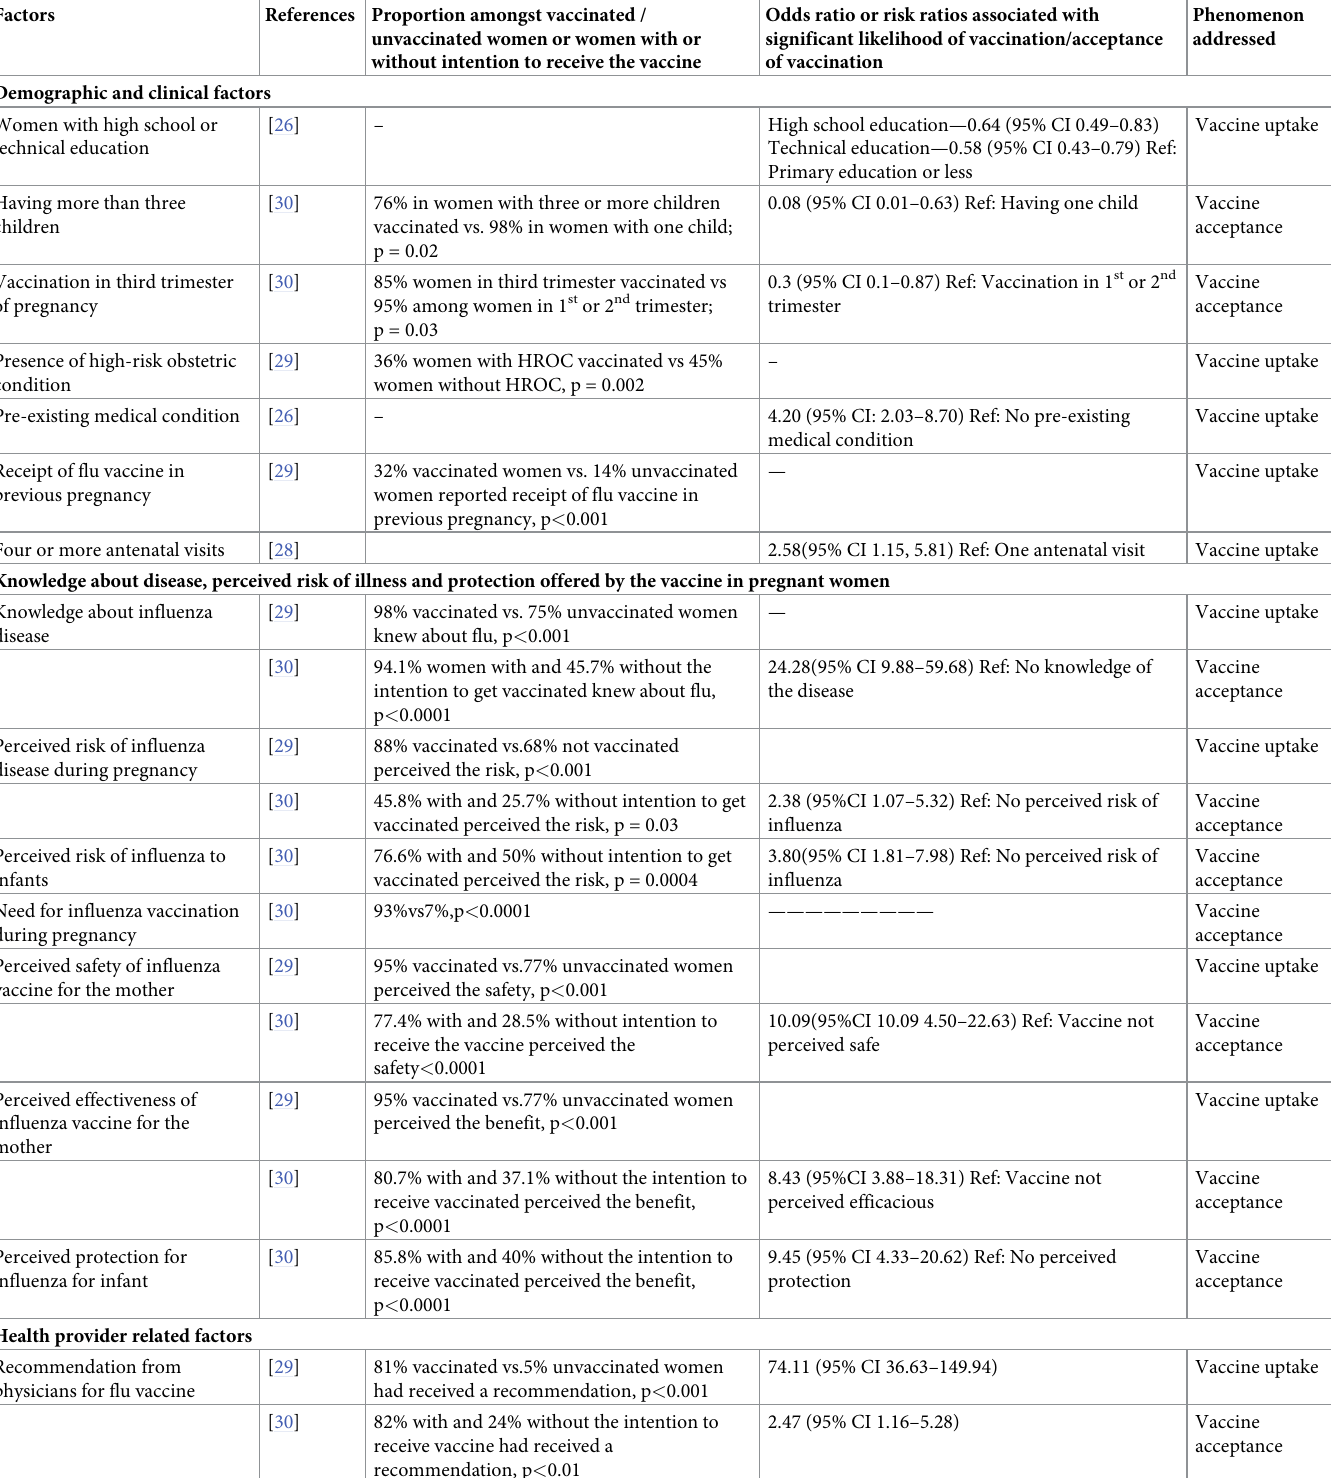
Table 3. Factors associated with uptake and acceptance of maternal influenza vaccine amongst pregnant women and/or health care